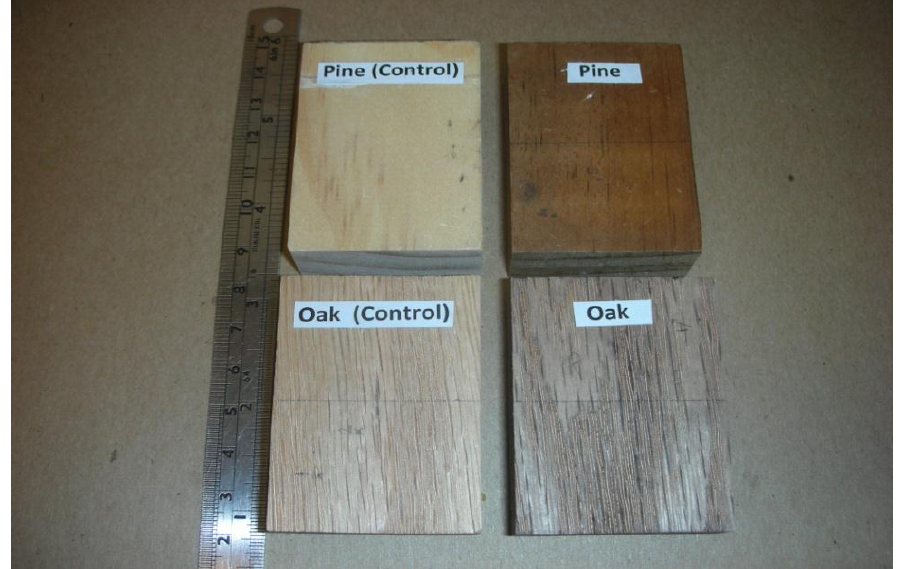
Figure 1. Heat-treated and control samples of pine and